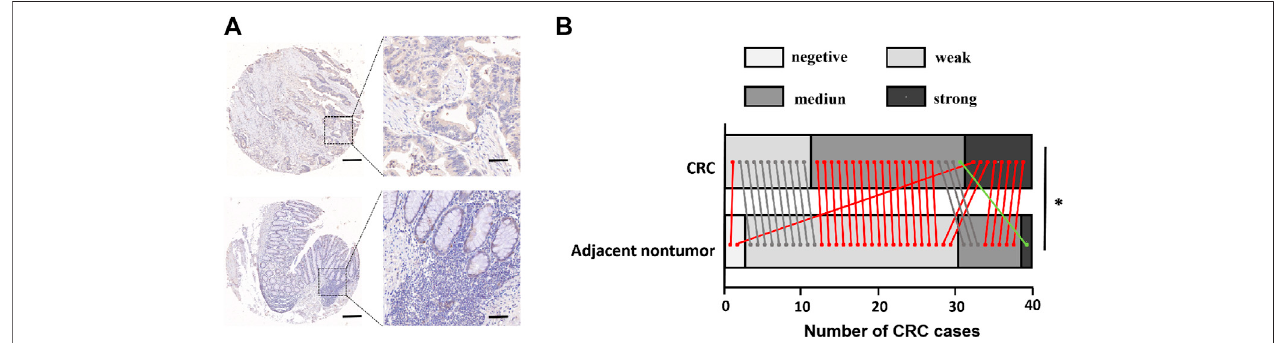
FIGURE 6 | FCRLB protein was highly expressed in CRC. (A) Representative image of immunohistochemical staining of FCRLB on a TMA containing 40 pairs of CRC and adjacent normal tissues. Scale bars = 500 μ m (right) or 100 μ m (left). (B) Statistical analysis of IHC staining results for FCRLB from the CRC tissue microarray slide. * p <